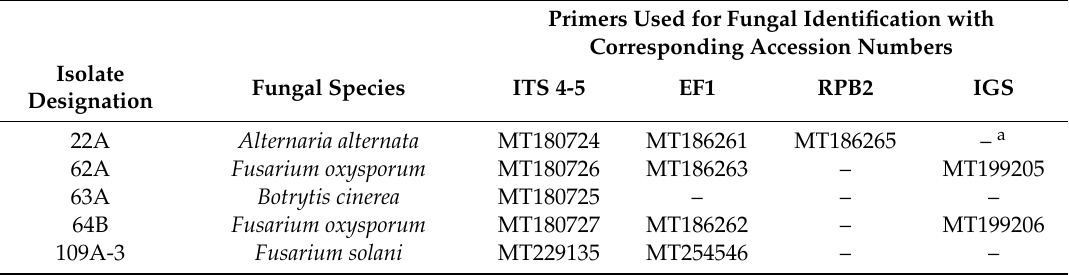
Table 2. Primers used for fungal identification of the most frequent pathogens of medical cannabis (MC) (Figure 1) in this study, and their corresponding accession numbers deposited in GenBank.